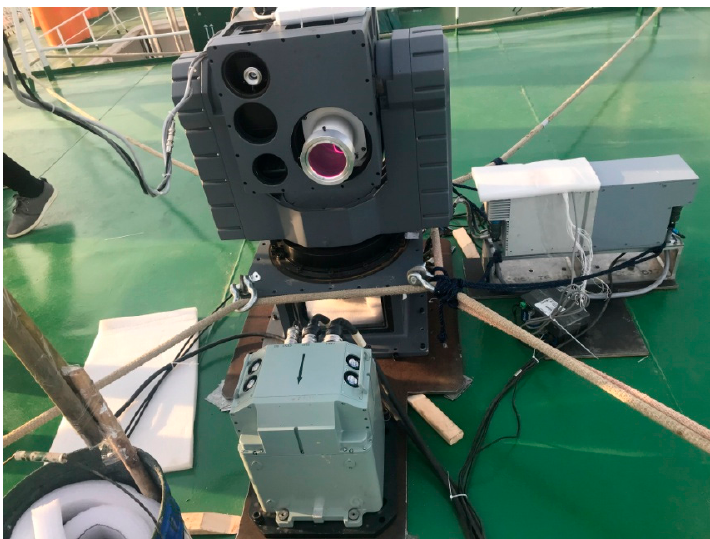
Figure 6. The shipborne ATP system. The shipborne ATP system shows the uplink beacon, coarse camera, and the attitude pre-compensation unit.